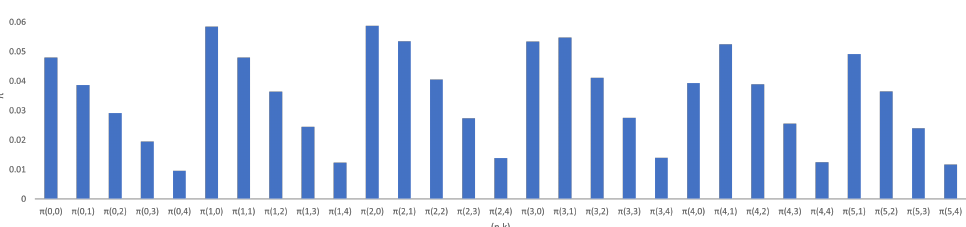
Figure 5. The probabilities with the maximal capacity of the system are equal to 5, and the maximal capacity of the inventory is equal to 4 using impatient customers under a uniform order